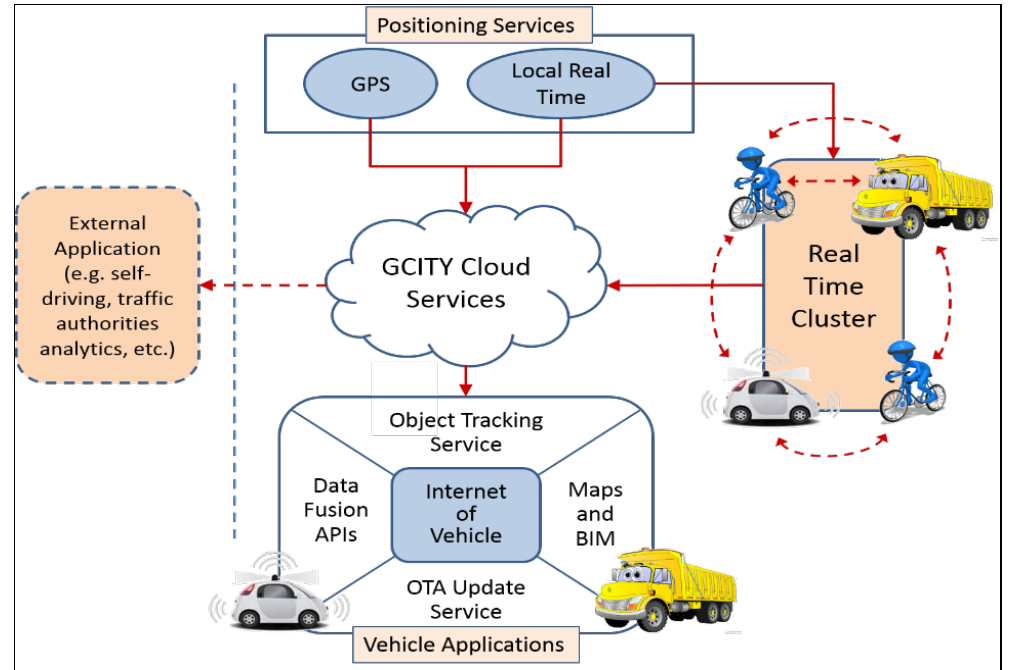
Figure 1. The GCITY Proposed